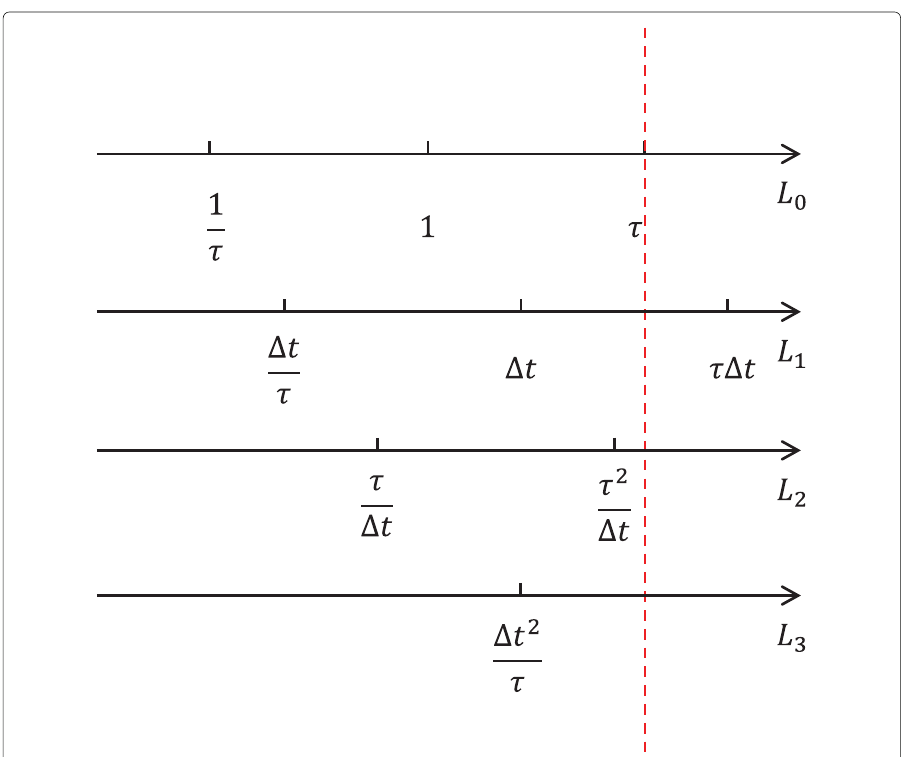
Fig. 3 Order sequence of the modified Eq. 43. L 0 axis shows the order sequence of the top three order terms in L 0 , L 1 axis shows the order sequence of the top three order terms in L 1 , L 2 axis shows the order sequence of the top three order terms in L 2 , L 3 axis shows the order sequence of the top three order terms in L 3 . Terms that have a higher order than τ need to be included in the calculation of the first three asymptotic expansions of the modified